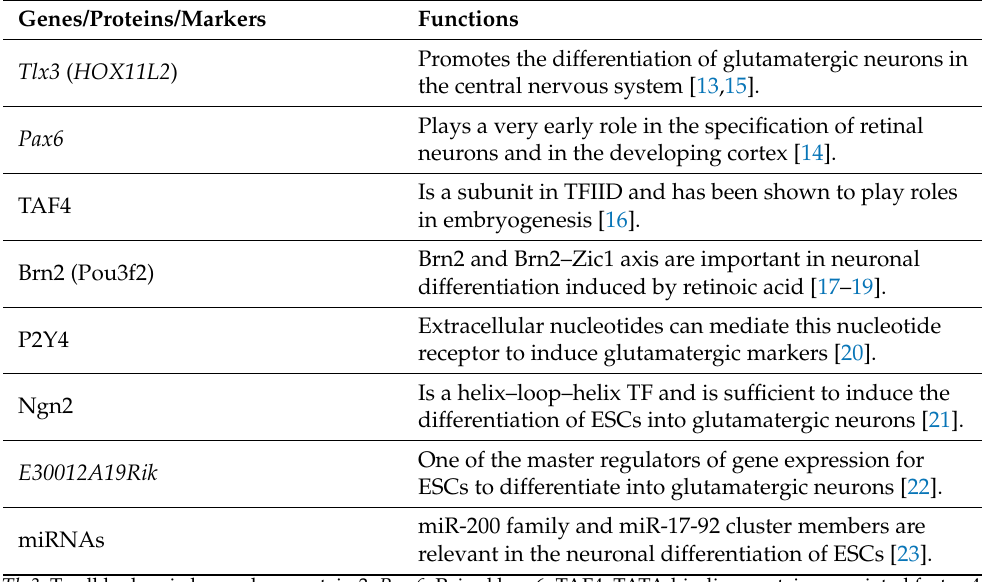
Table 1. The genes, proteins and markers involved in the cellular differentiation process in